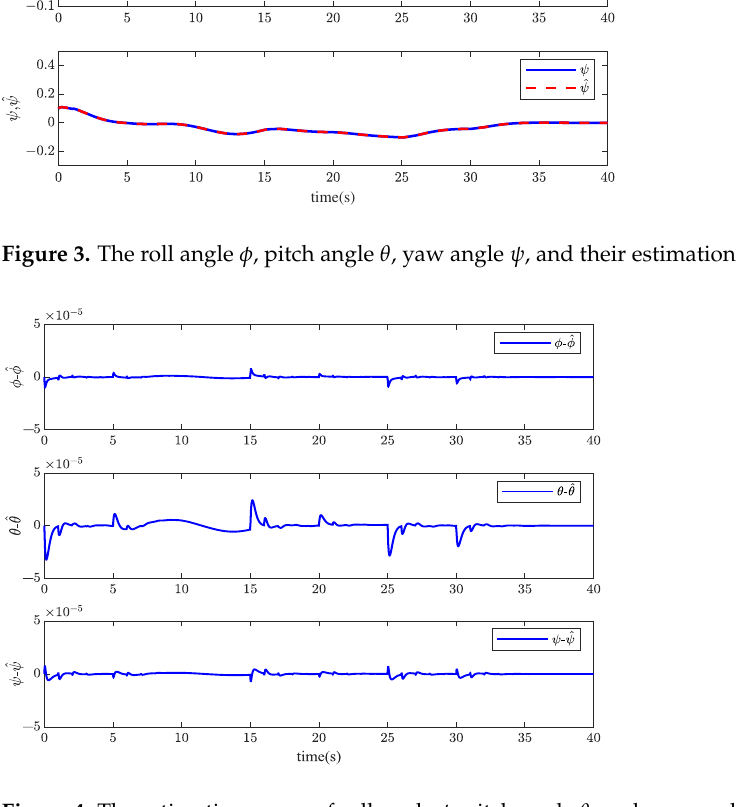
Figure 4. The estimation errors of roll angle φ , pitch angle θ , and yaw angle ψ when z = 1